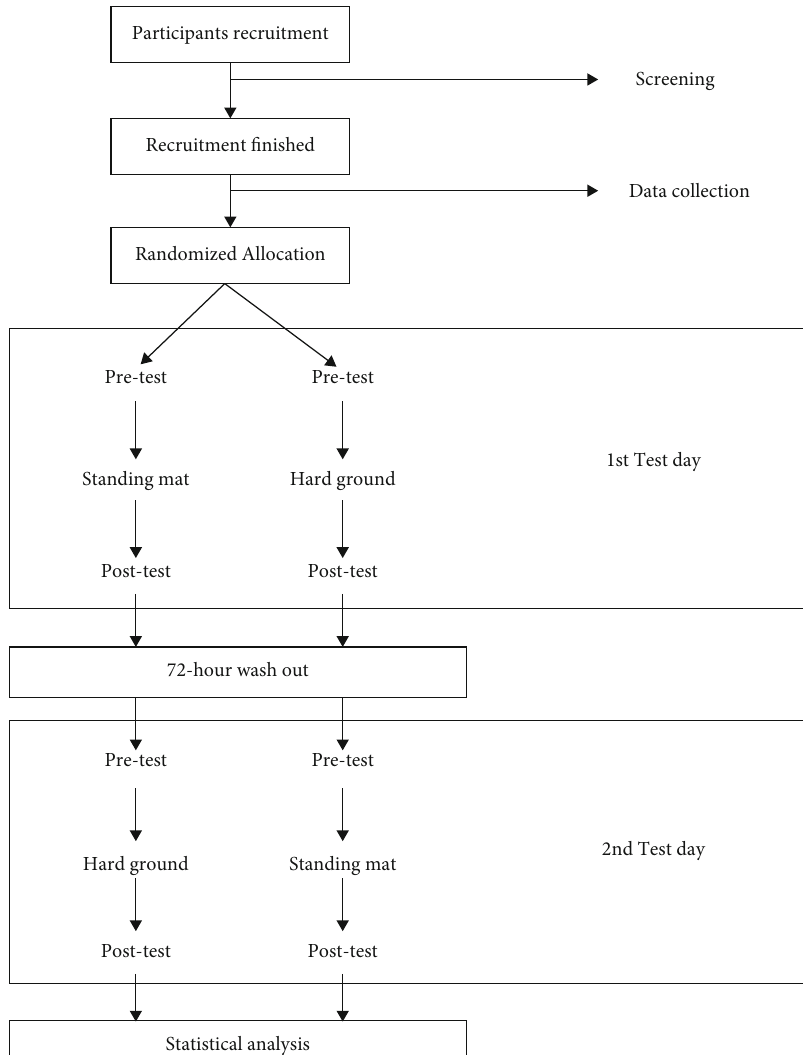
Figure 2: The schematic diagram of the